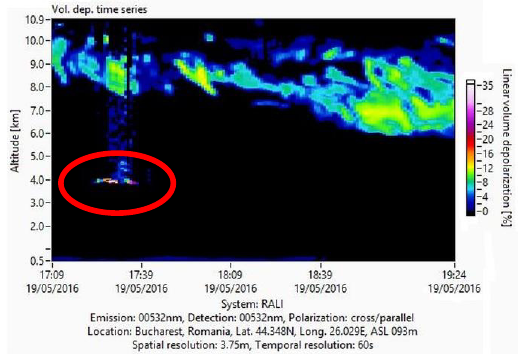
Figure 5 Lidar time series of VDR for May 19 th 2016 Vertical distribution of atmospheric